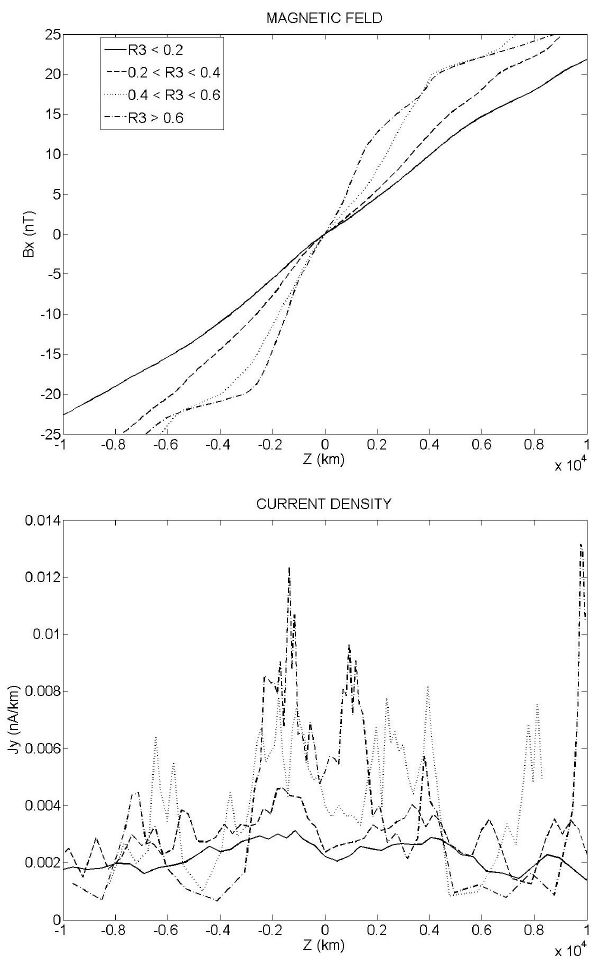
Fig. 10. Profiles of the magnetic field B x (z) (top) and the electric current density distributions j y (z) in the geotail current sheet for different temperature anisotropy ratios R 3